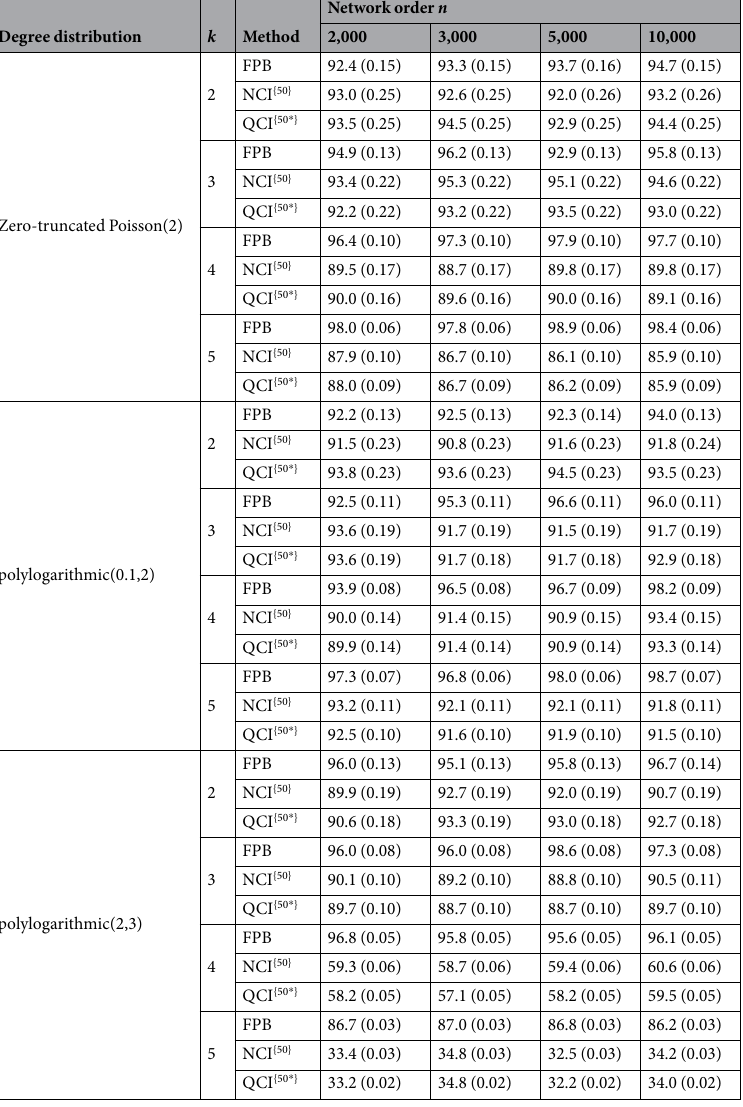
Table 1. Coverage of theoretical probabilities f ( k ) of observing a node of degree k , k = 2, … , 5, by 95% confidence intervals for varying network orders. Average interval width is given in parentheses. Methods of obtaining confidence intervals are fast patchwork bootstrap (FPB), normal interval based on estimated proportions and their variance using 50 random nodes (NCI {50} ), and bootstrap of 50 random nodes (QCI {50 * } ). Number of bootstrap resamples is 500. Number of Monte Carlo simulations is